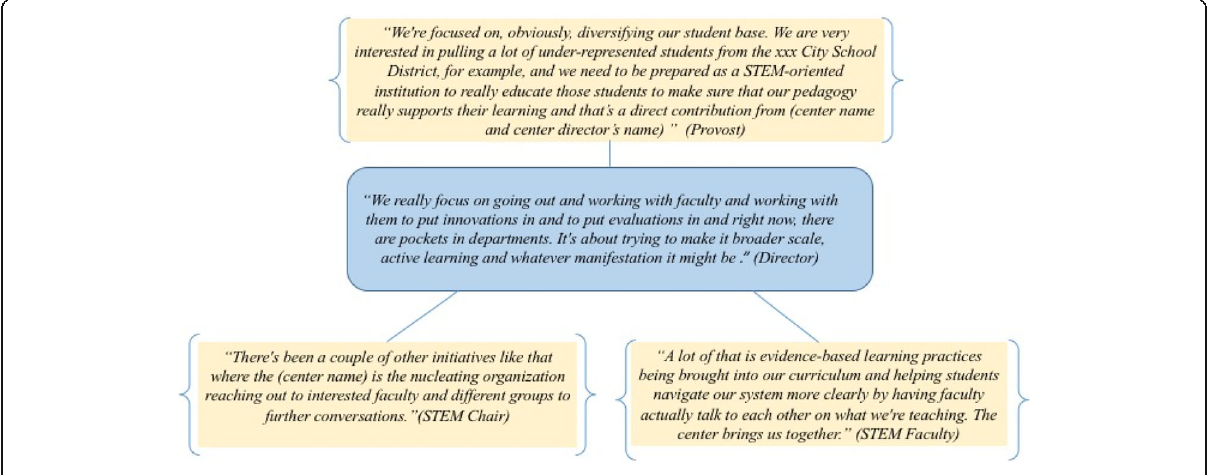
Fig. 2 Improved teaching supports broader participation. A representative example from Institution